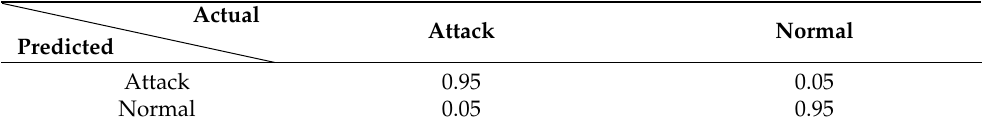
Table 6. Confusion matrix based on our suggested technique for four unique occurrences (TP, FP, TN, and FN). Actual Attack Normal Predicted Attack 0.95 0.05 Normal